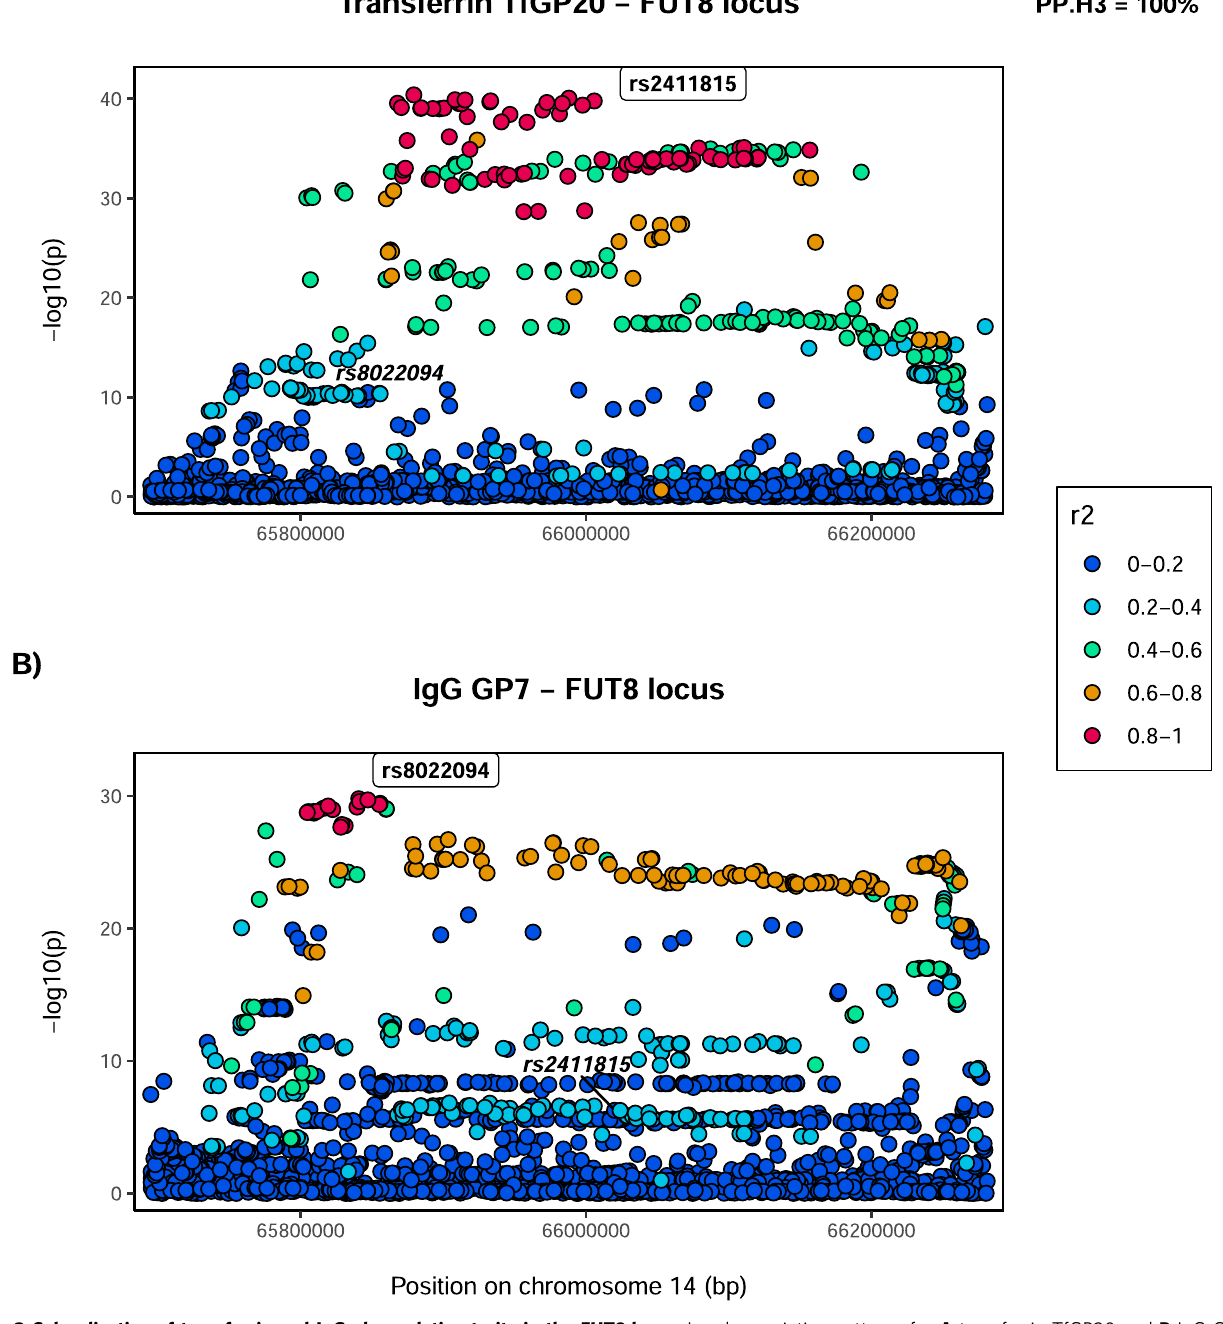
Fig. 3 Colocalisation of transferrin and IgG glycosylation traits in the FUT8 locus. Local association patterns for A transferrin TfGP20 and B IgG GP7 glycans at the FUT8 locus. TfGP20 and IgG GP7 association patterns do not colocalise, with PP.H3 (posterior probability for hypothesis 3, of different causal variants) of 100%. Colocalisation patterns are not reported since the width of the FUT8 region makes the plot non-informative. SNP most strongly associated in the region with the listed glycan trait is reported in bold and labelled. For comparison, SNP most strongly associated with the other listed glycan trait is reported in italic, in the same